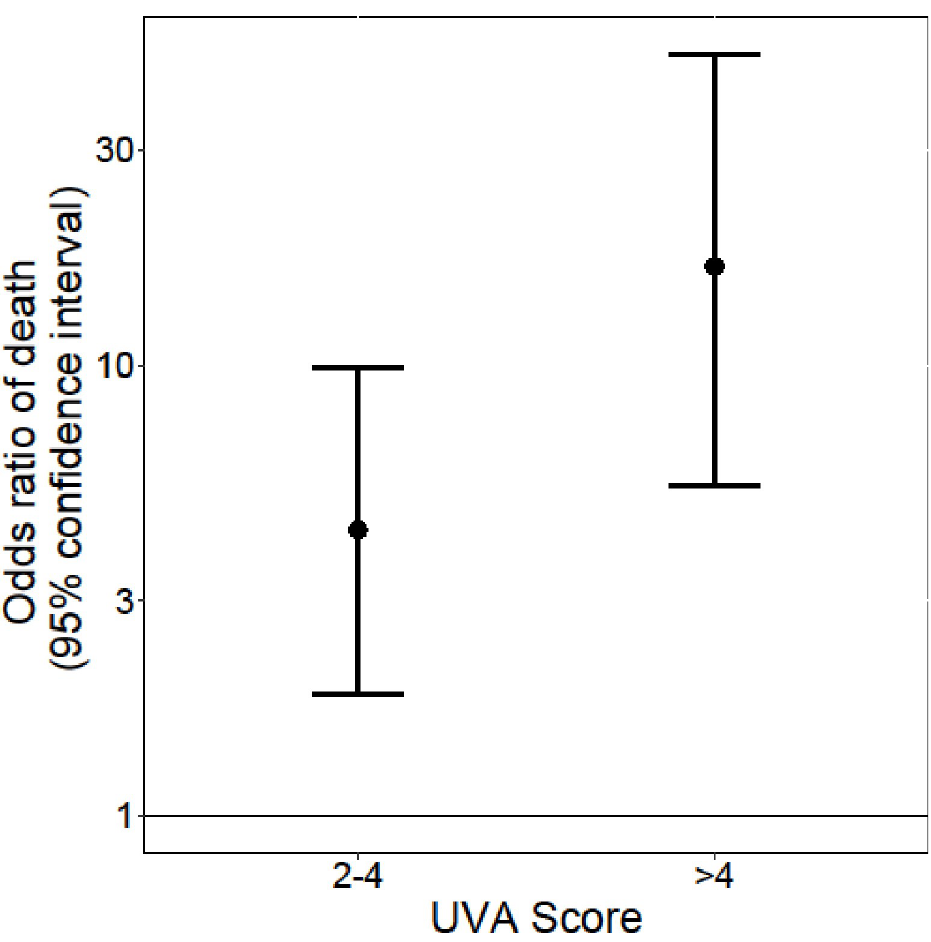
Fig 4. Odds ratios with 95% confidence intervals for in-hospital mortality associated with medium (2–4) and high ( > 4) risk UVA score categories compared to the low (0–1) risk UVA score category for adult patients admitted to hospital with acute infection in Gitwe, Rwanda.